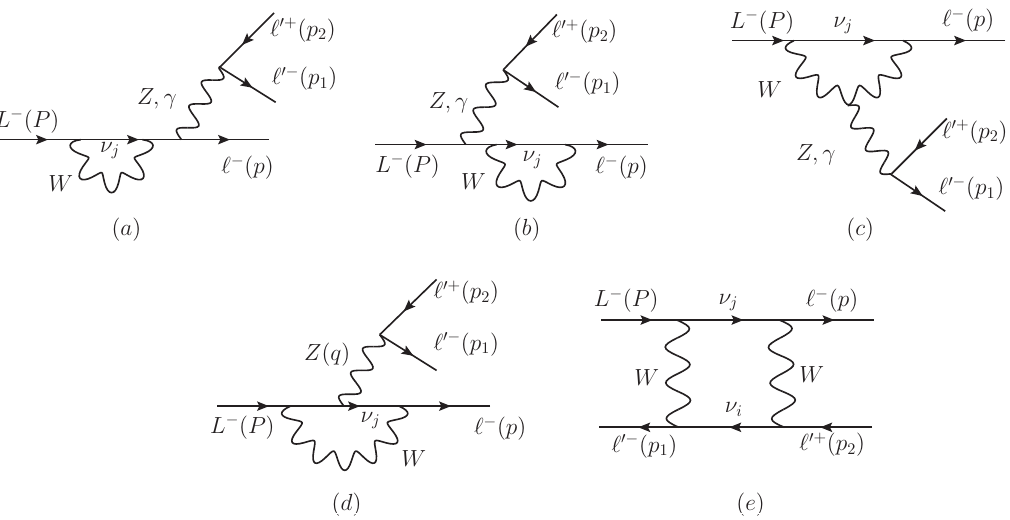
Figure 1: Feynman diagrams for the L − → (cid:96) − (cid:96) (cid:48)− (cid:96) (cid:48) + decays in the presence of lep- ton mixing. Similar diagrams replacing the W boson by the respective would-be Goldstone must be added in renormalizable R ξ gauges. Additionally, when (cid:96) = (cid:96) (cid:48) similar contributions (exchanging p ↔ p ) to the amplitudes of diagrams (a) to (e) 1 must be subtracted in order to antisymmetrize the amplitude. On the other hand, when (cid:96) (cid:54) = (cid:96) (cid:48) , since the vertices of the neutral bosons γ and Z with a pair of fermions are flavor-conserving, only a similar (e) box diagram must be added interchanging (cid:96) ( p ) ↔ (cid:96) (cid:48) ( p ) 1